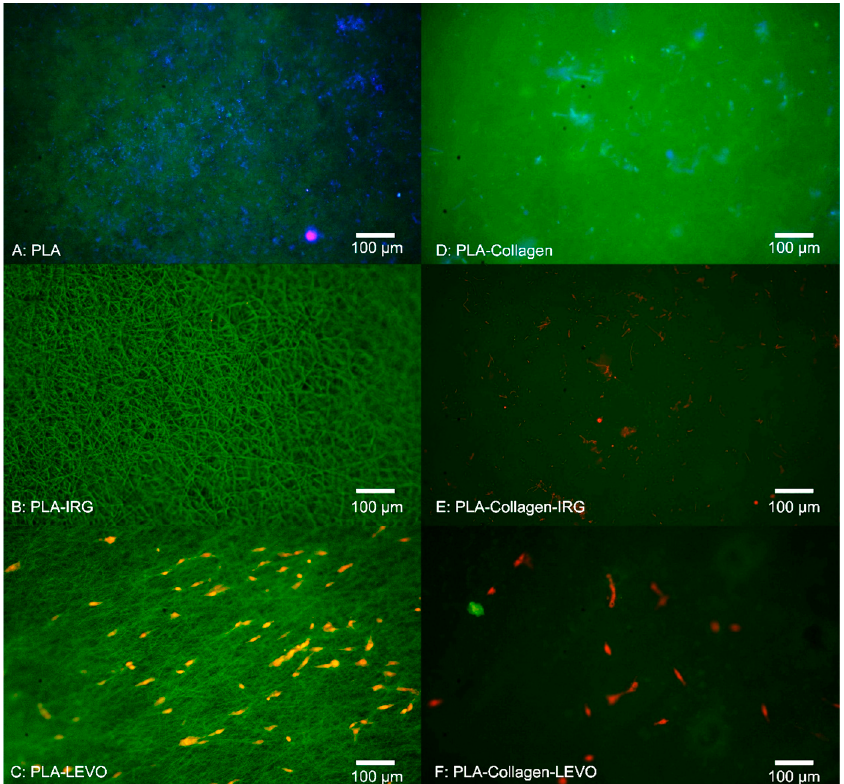
Figure 3. Fluorescent images of cell adhesion assay for RAOSMCs after 3 days ( A ) polylactic acid (PLA) ( B ) PLA–IRG ( C ) PLA–LEVO ( D ) PLA–collagen ( E ) PLA–collagen–IRG ( F ) PLA–collagen–